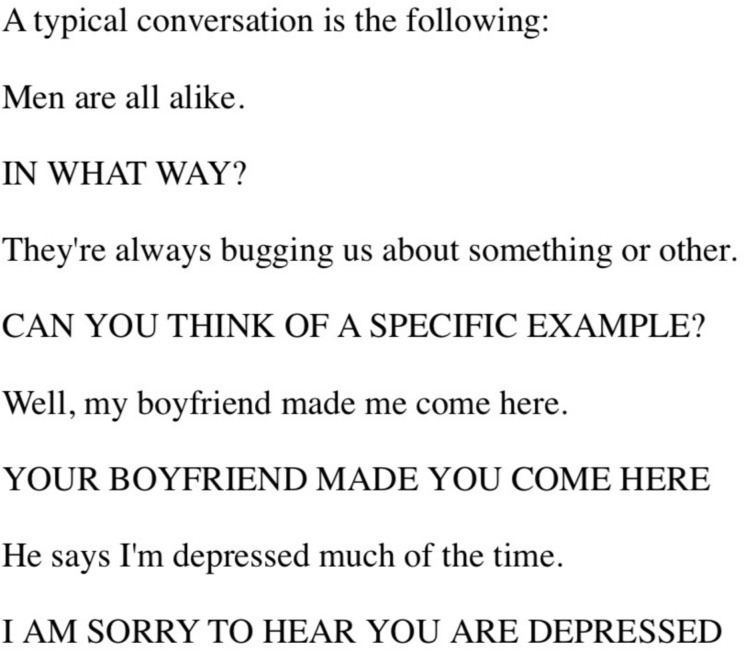
Conversation beween a human and chatbot [Reprinted with permission Weizenbaum (1966)].